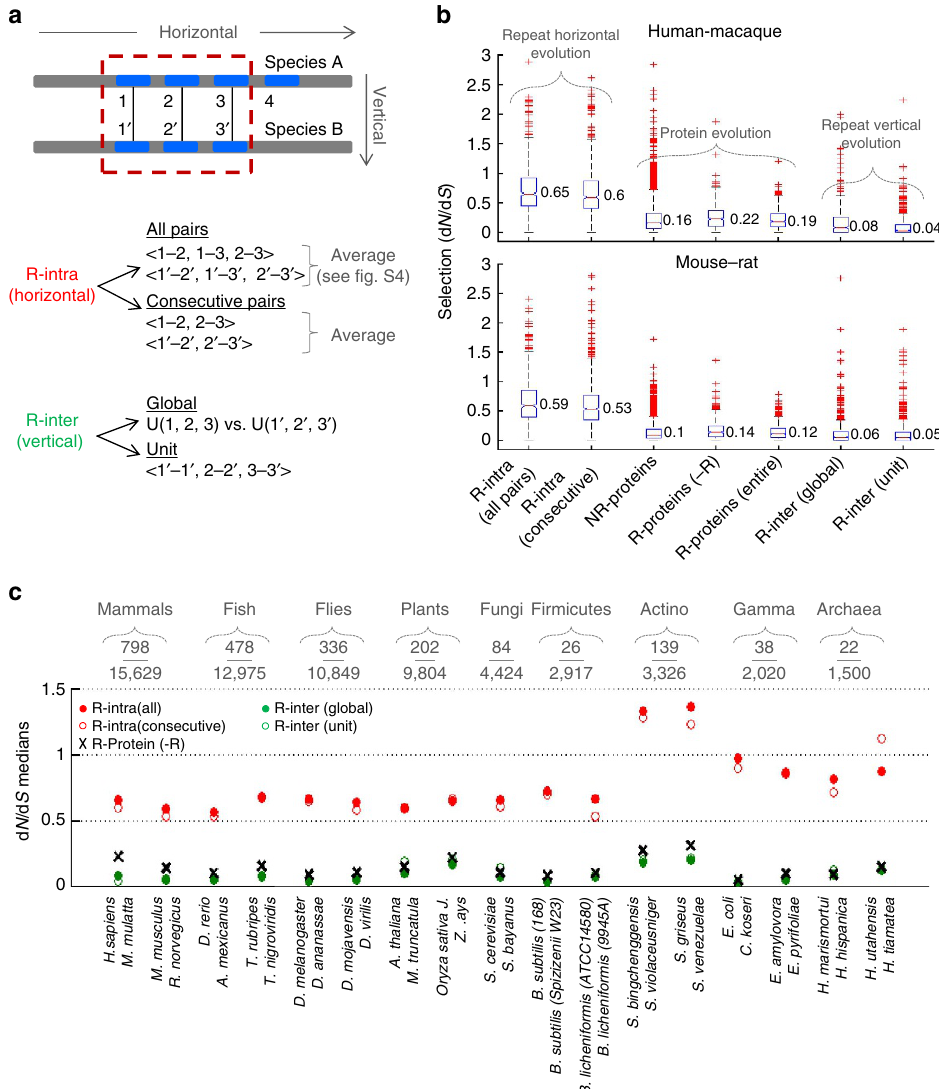
Figure 5 | Selection in the horizontal and vertical evolution of repeats in sets of orthologous proteins. ( a ) Schematic illustration of two aligned orthologous proteins from species A and species B, containing 4 and 3 repeats (marked as blue segments), respectively. Both horizontal and vertical selection measures are based on all orthologous repeats (indicated by the dashed box). Horizontal selection (R-intra) is given by the average across species of o d N/ d S 4 (Supplementary Fig. 4), where o d N/ d S 4 is estimated twice: once as the average d N/ d S of all repeat pairs within a protein/species, and second as the average d N/ d S of all consecutive pairs of repeats. Vertical selection (R-inter) is estimated, once globally, by the d N/ d S of merged segments of orthologous repeats, and locally (unit-based), by the average d N/ d S of all orthologous repeat pairs. ( b ) Distribution of d N/ d S for the horizontal evolution of repeats in repeat (R) containing proteins ( n ¼ 798), followed by the distribution of d N/ d S of complete proteins: non-repetitive (NR) proteins ( n ¼ 10,086), and repetitive proteins, with (entire) or without ( (cid:2) R) the repetitive part, followed by d N/ d S distributions for the vertical evolution of repeats. ( c ) The medians of the distributions in b for all pairs of organisms within each quartet or pair of species. At the top, the numbers of orthologous repetitive proteins relative to the number of all orthologous proteins in each quartet or pair are shown. For the complete d N/ d S distributions of all species pairs, see Supplementary Fig.